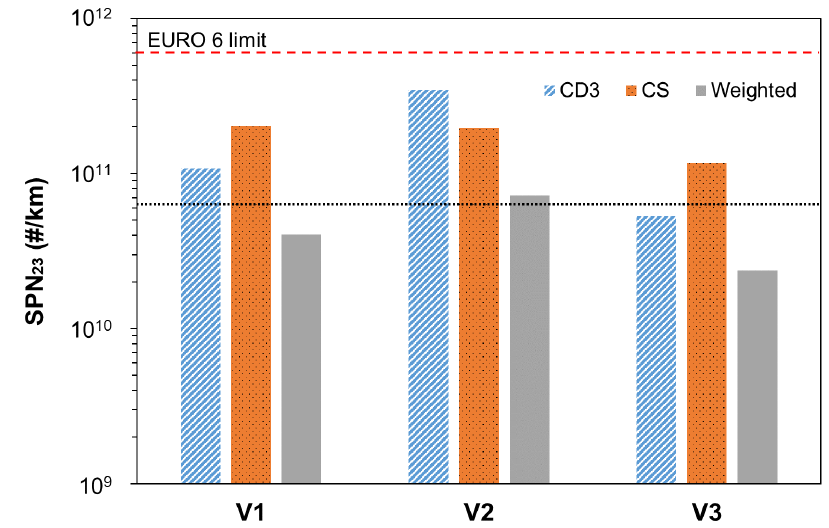
Figure 1. Solid particle number emissions (>23 nm) (SPN 23 ) of three plug-in hybrid electric vehicles (V1 to V3) at the Type 1 test WLTC during charge-depleting (CD) and charge-sustaining (CS) rechargeable electric energy storage (REESS) conditions as well as the weighted SPN 23 emissions considering the electric range calculated according the regulation 2017/1151. The internal combustion engine (ICE) ignited for first time during the third consecutive CD cycle (CD3) for all vehicles. In CD1 and CD2, the vehicle was powered only by the electric motor and these cycles were not plotted as SPN 23 (#/km) was zero. The red dashed line shows the Euro 6 limit (6 × 10 11 #/km) and the black dotted line shows the average WLTC SPN 23 emissions of eight conventional Euro 6d/6d-TEMP gasoline direct injection vehicles [34].